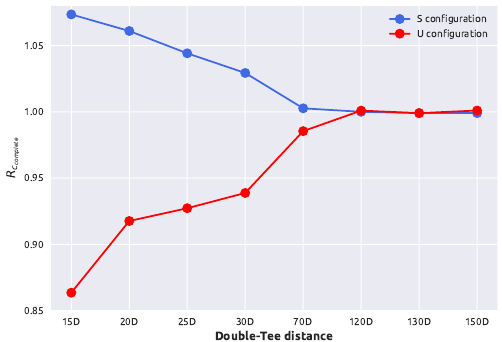
Figure 6. Relation between the outlet conductivity ratio R c